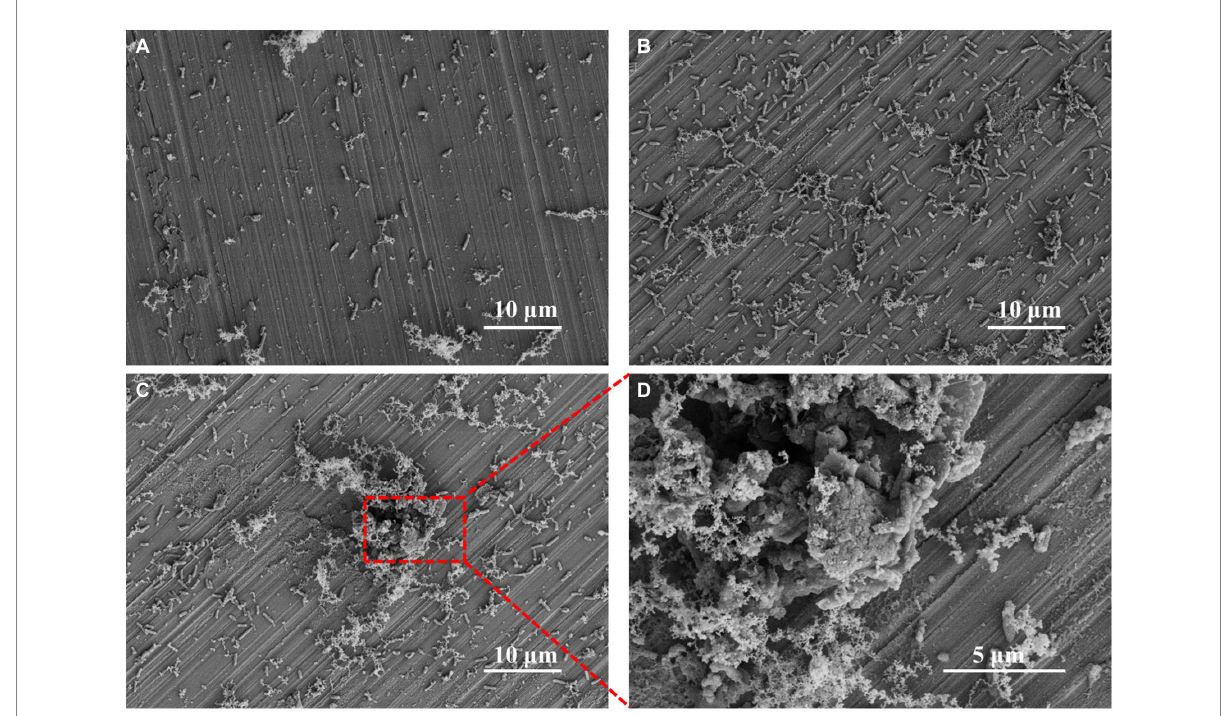
FIGURE 1 SEM images of Pseudomonas aeruginosa on HEA coupon surfaces after (A) 3 days, (B) 7 days, (C) 14 days and (D) the enlarged image of the figure C